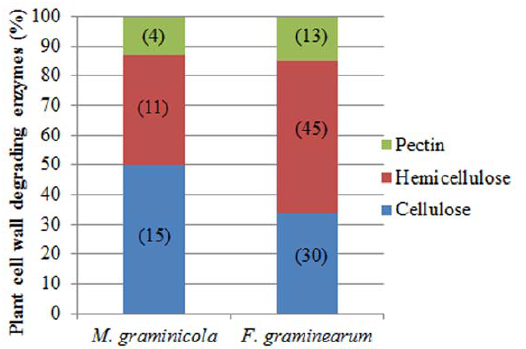
Figure 3. Comparison of the distribution of functional categories (main PCWDEs) identified in the predicted secre- tomes of M.graminicola and F.graminearum . The various enzyme classes are given along with the actual number of enzymes in each class (in brackets).